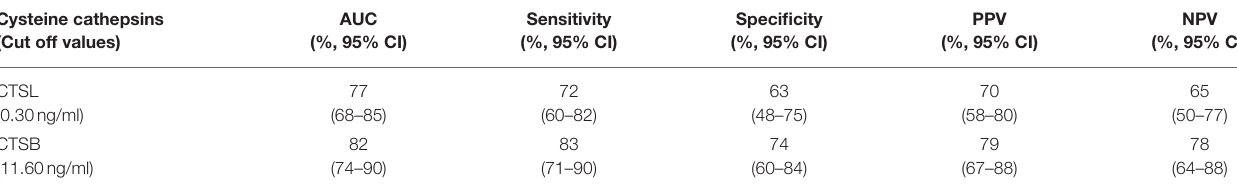
TABLE 4 | Assessment of diagnostic performance of serum cysteine cathepsins in GBC. Cysteine cathepsins (Cut off